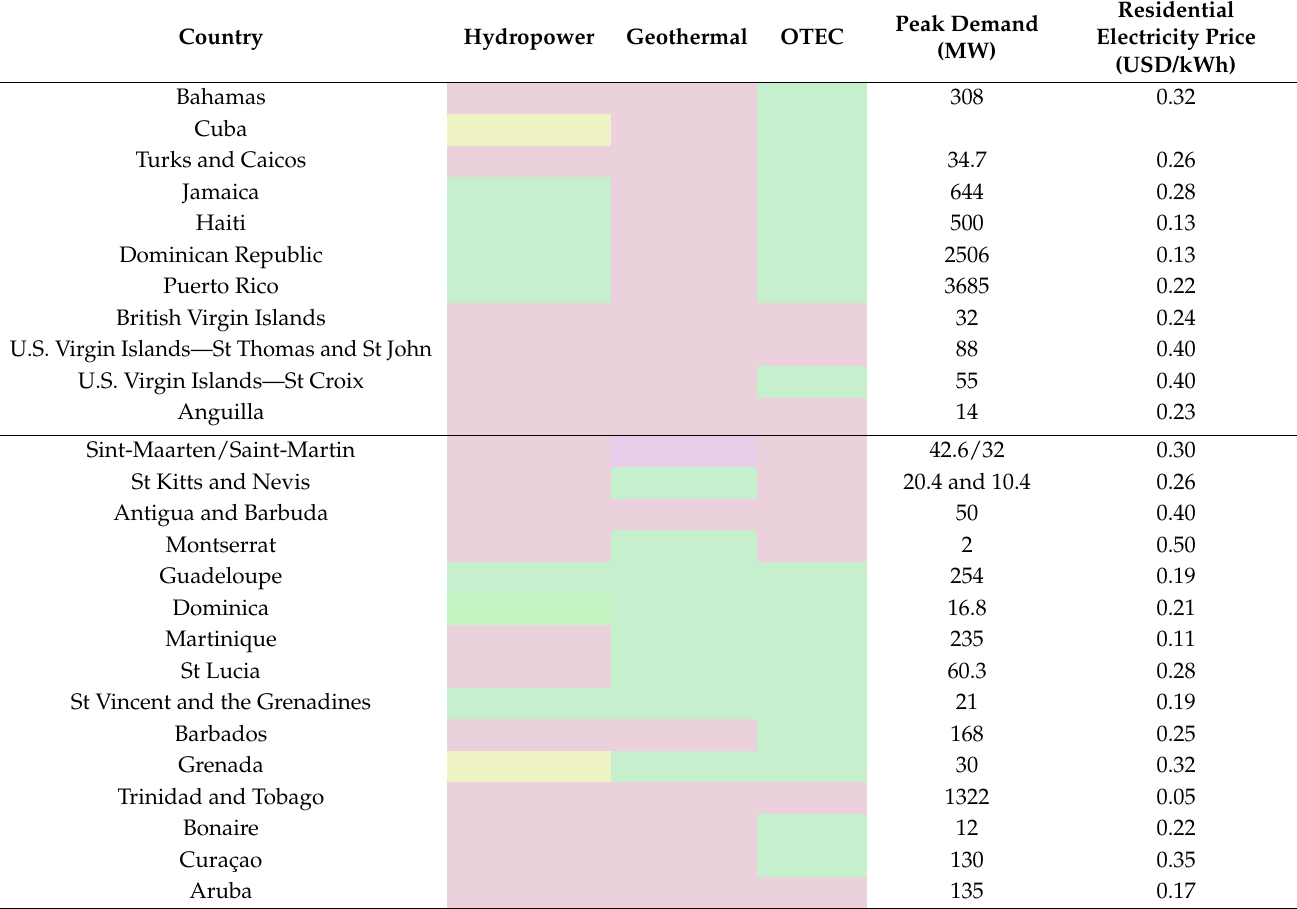
Table 1. List of Caribbean countries with yes (green) or no (light red) filters for potential hydropower, geothermal and ocean thermal energy conversion (OTEC) technologies as dispatchable renewable energy. For OTEC in this table, no filtering has been done for resources to determine proximity to population centers or other infrastructure. In some cases (yellow), hydropower resources may be small, either in absolute terms or in comparison to the overall system capacity. Additional information for reference purposes on peak demand and electricity price by country, the latter adapted from NREL [23].